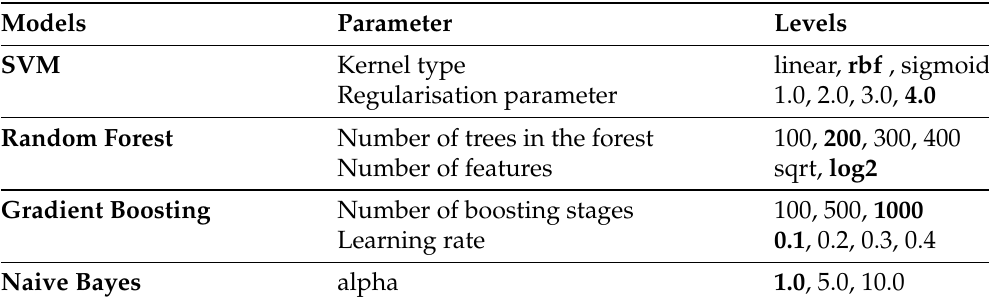
Table 3. Grid search parameters and levels for machine learning models when applying text prepro- cessing techniques.